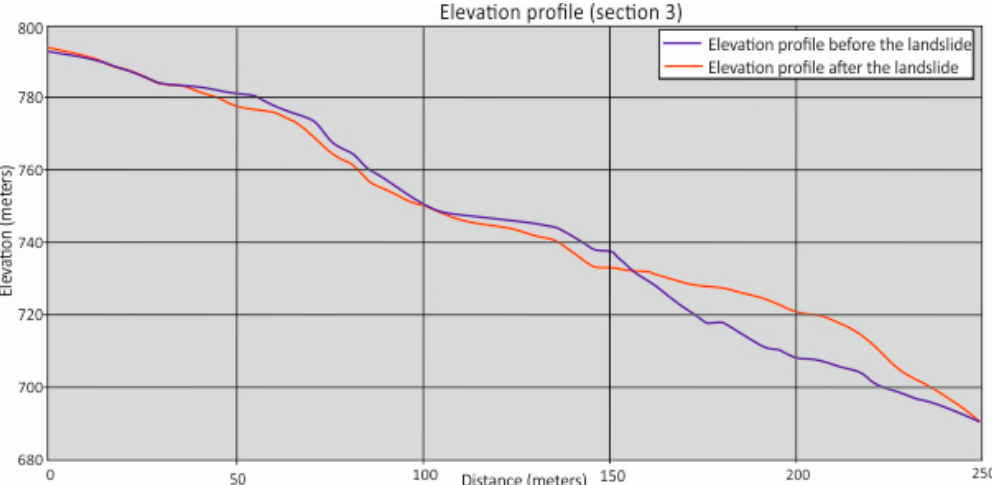
Figure 12. Elevation profiles of section 3 in Figure 11.